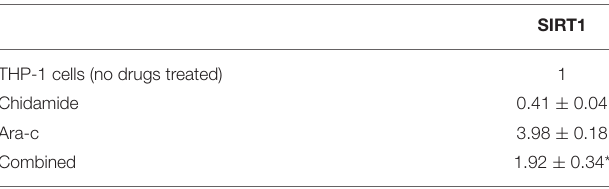
TABLE 5 | The relative value change of SIRT1 mRNA expression in THP-1 cell lines treated by chidamide, Ara-c, and Ara-c combined with chidamide.